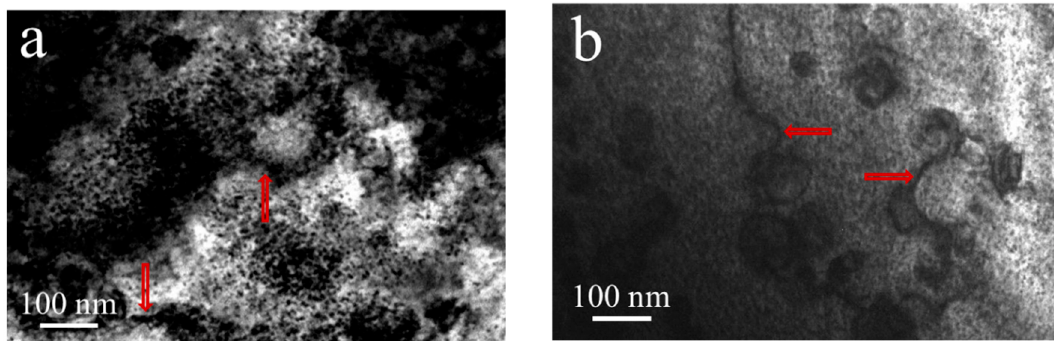
Figure 6. Microstructures of the dislocations of the 7075 Al sheets along the [001] Al zone axis: ( a ) Figure6. Microstructuresofthedislocationsofthe7075Alsheetsalongthe[001] Al zoneaxis: ( a )one-step one-step aging for 16 h at 140 °C and ( b ) DA treatment (3 h at 120 °C and 3 h at 160 °C). aging for 16 h at 140 ◦ C and ( b ) DA treatment (3 h at 120 ◦ C and 3 h at 160 ◦